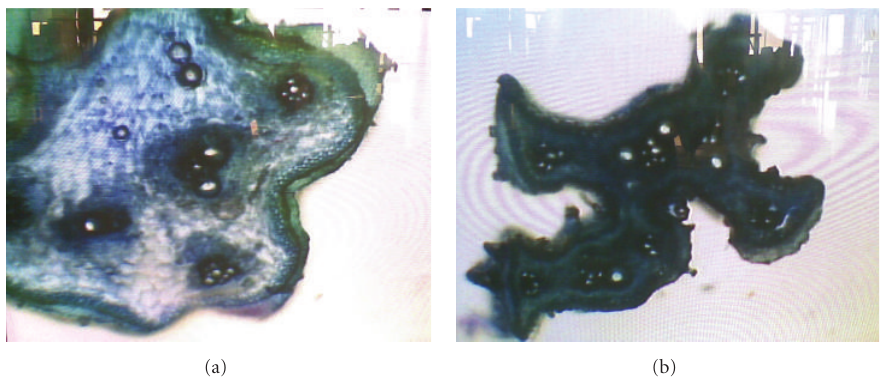
Figure 10: Comparison of stem cross-sections for (a) una ff ected part of microwave-treated plant and (b) a part of the same stem a ff ected by 10 seconds of microwave treatment using the small aperture horn antenna (microscopic observations made 5 days after microwave treatment).